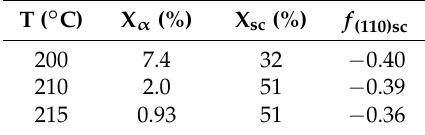
Figure 7. DSC heating curves of PLLA/PDLA-60-2 fibers annealed at various temperatures. Table 4. The phase content and orientation factor of PLLA/PDLA-60-2 fibers cooling from various temperatures.